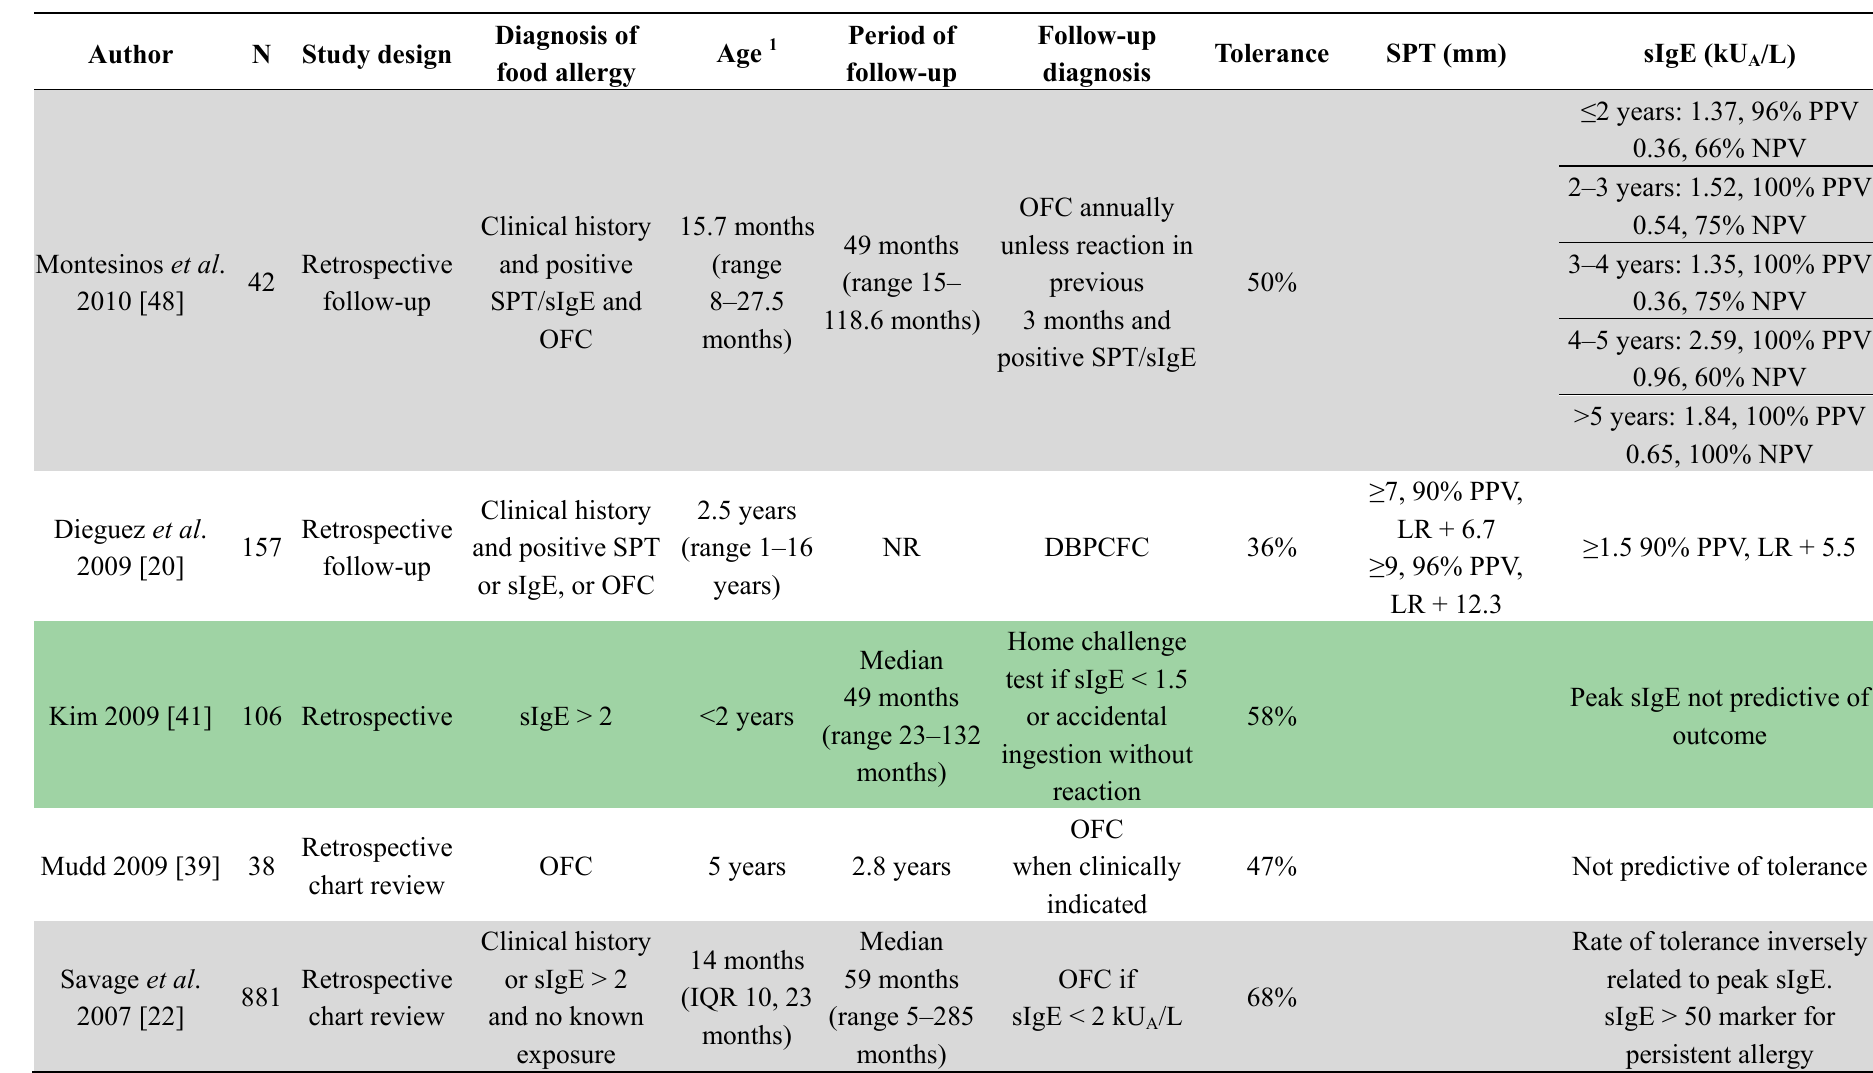
Table 2. Studies reporting on SPT and sIgE and the prognosis of EGG